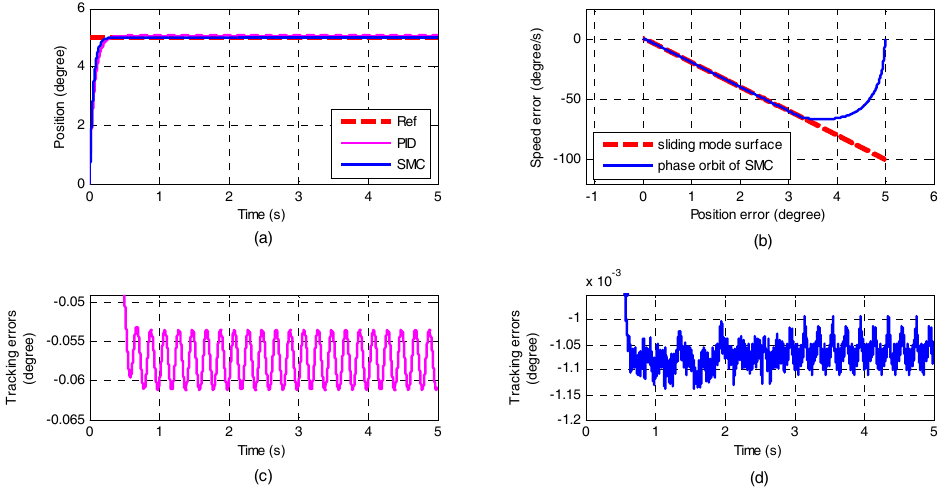
Figure 4. Simulation of step response of Joint 1: ( a ) Position tracking; ( b ) Phases trajectory diagram of SMC; ( c ) Tracking error of PID (proportional-integral-derivative); and ( d ) Tracking error of SMC (sliding mode controller).